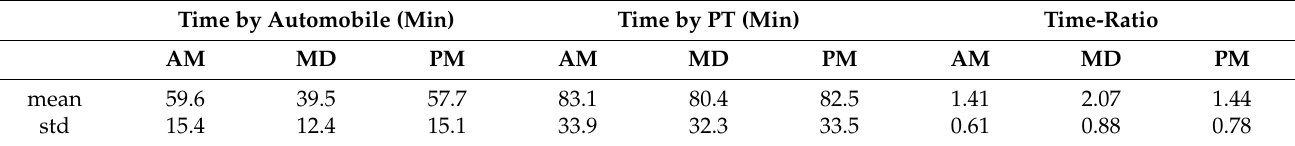
Table 1. Travel time by two modes and time-ratio for the three time periods.